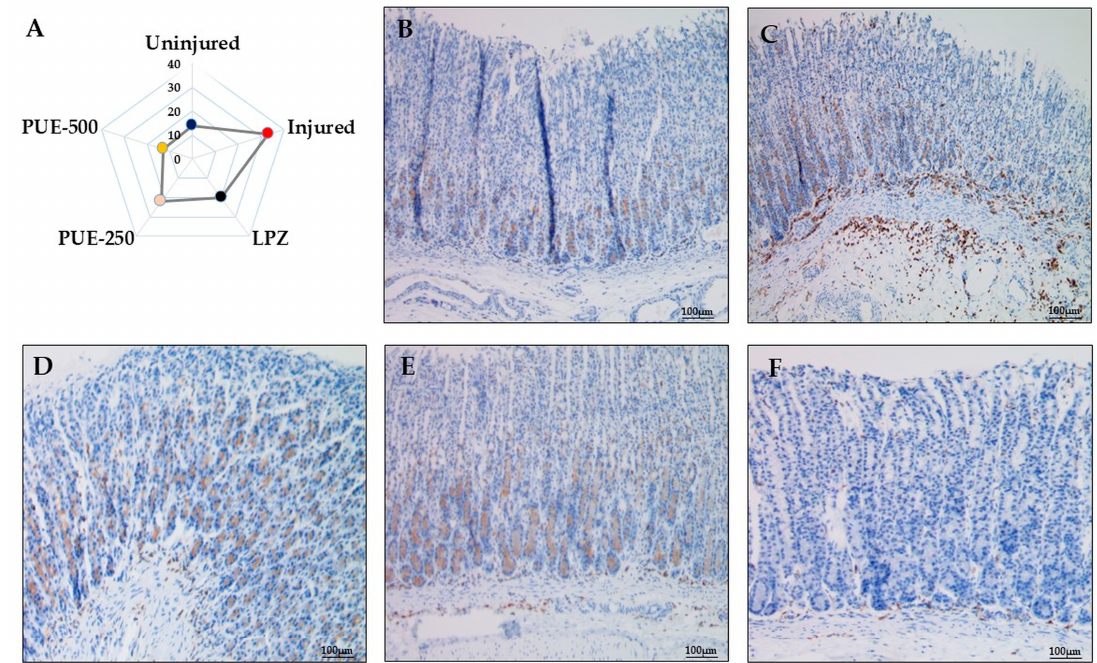
Figure 6. Immunohistochemical analysis of leukocyte common antigen (LCA, CD45) in the treatment groups. ( A ) Radar graph indicating the % IEL infiltration in a selected area of 100 cells; ( B ) in the uninjured group, smooth gastric mucosa showed a normal morphology and presence of a lower number of intraepithelial lymphocytes (fewer brown stains) with no infiltration ( × 100); ( C ) the injured group showed gastric mucosa with a large number of intraepithelial lymphocytes (more browning) and more infiltration ( × 100); ( D ) LPZ (30 mg/kg of lansoprazole) showed little infiltration of lymphocytes into the gastric epithelial layer ( × 100), ( E ) PUE-250 (250 mg/kg of PUE), and ( F ) PUE-500 (500 mg/kg of PUE) groups with mild intraepithelial leukocytes ( ×